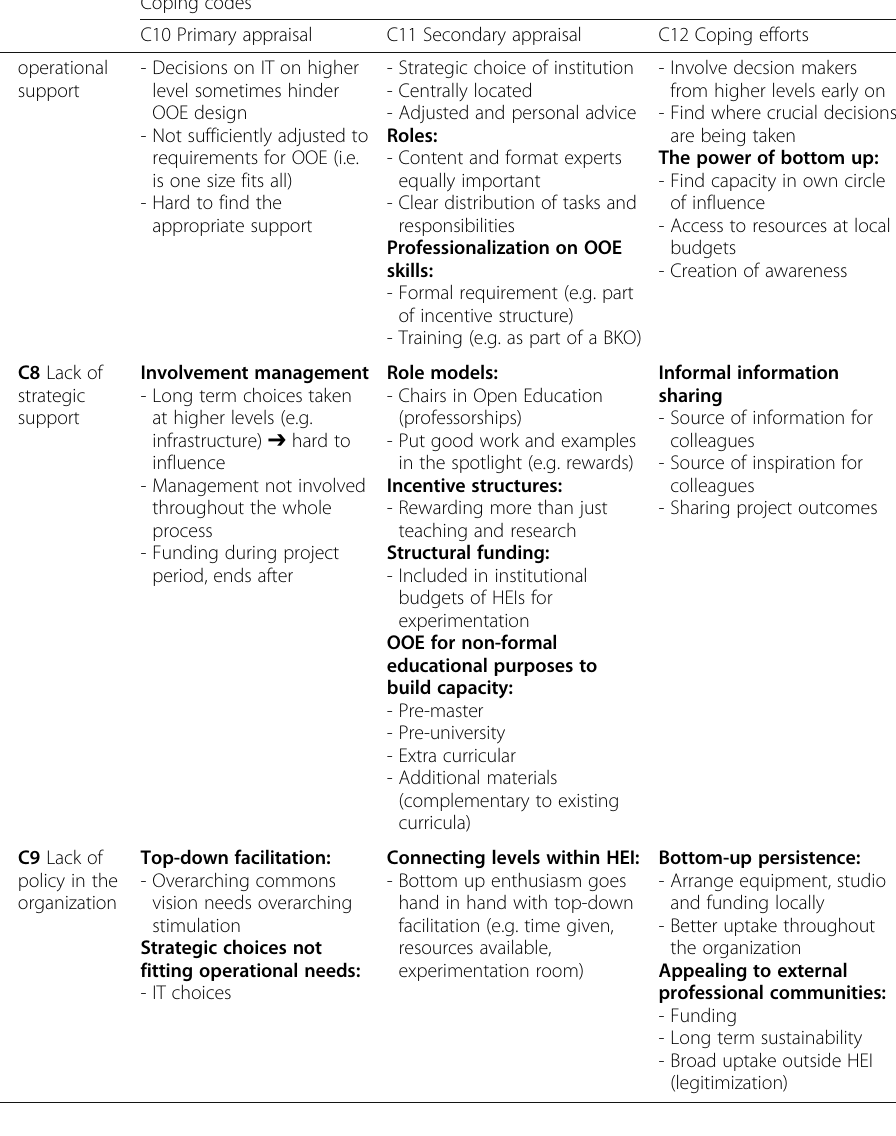
Table 6 Charting of focus group data